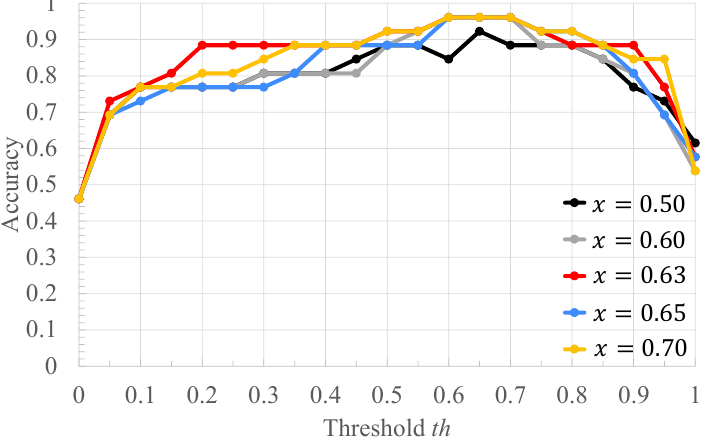
Figure 8. The accuracy of the proposed method when the threshold x used for RRI classification is varied.